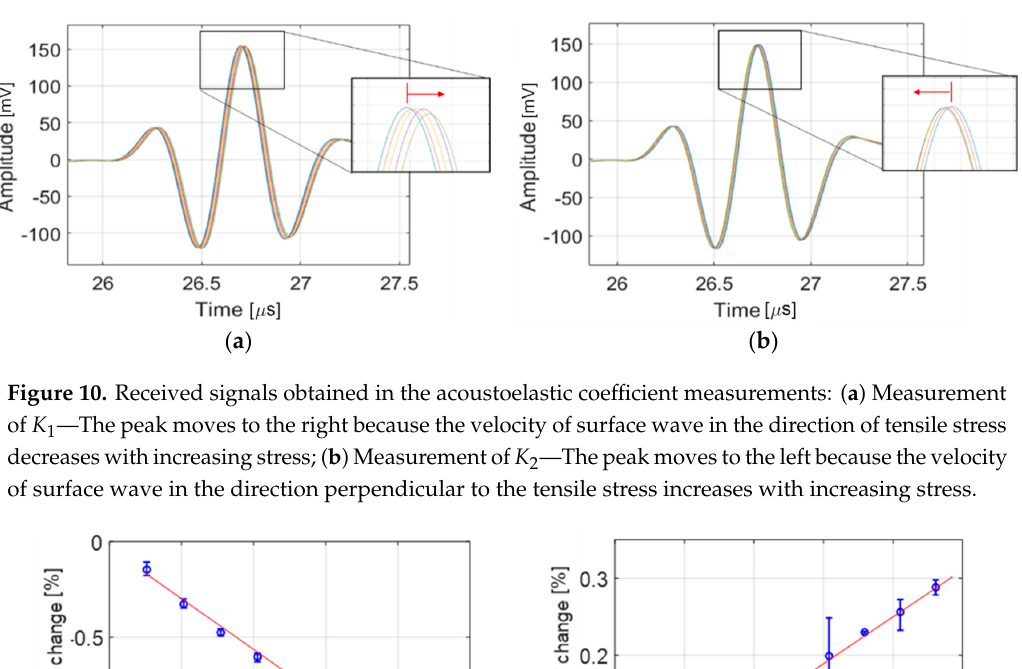
Figure 10. Received signals obtained in the acoustoelastic coefficient measurements: ( a ) Measurement of K 1 —The peak moves to the right because the velocity of surface wave in the direction of tensile stress decreases with increasing stress; ( b ) Measurement of K 2 —The peak moves to the left because the velocity of surface wave in the direction perpendicular to the tensile stress increases with increasing stress.